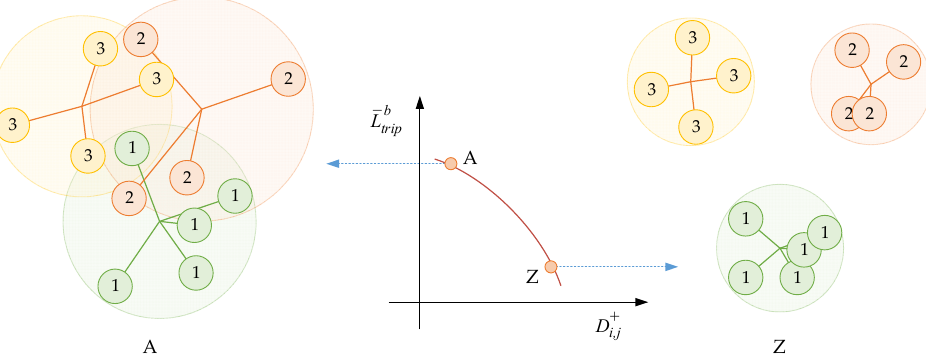
Figure 3. Diagram of clustering effect for batch similarity-based triplet loss.